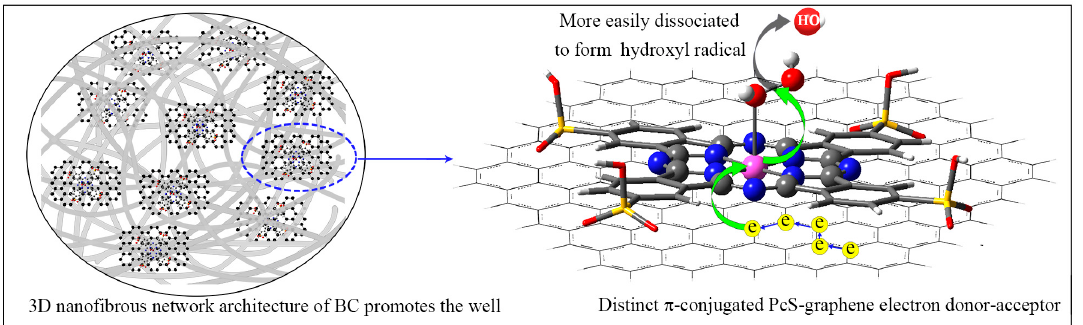
Figure 10. Illustration of synergistic enhancement of catalytic activity of PcS by BC and graphene.